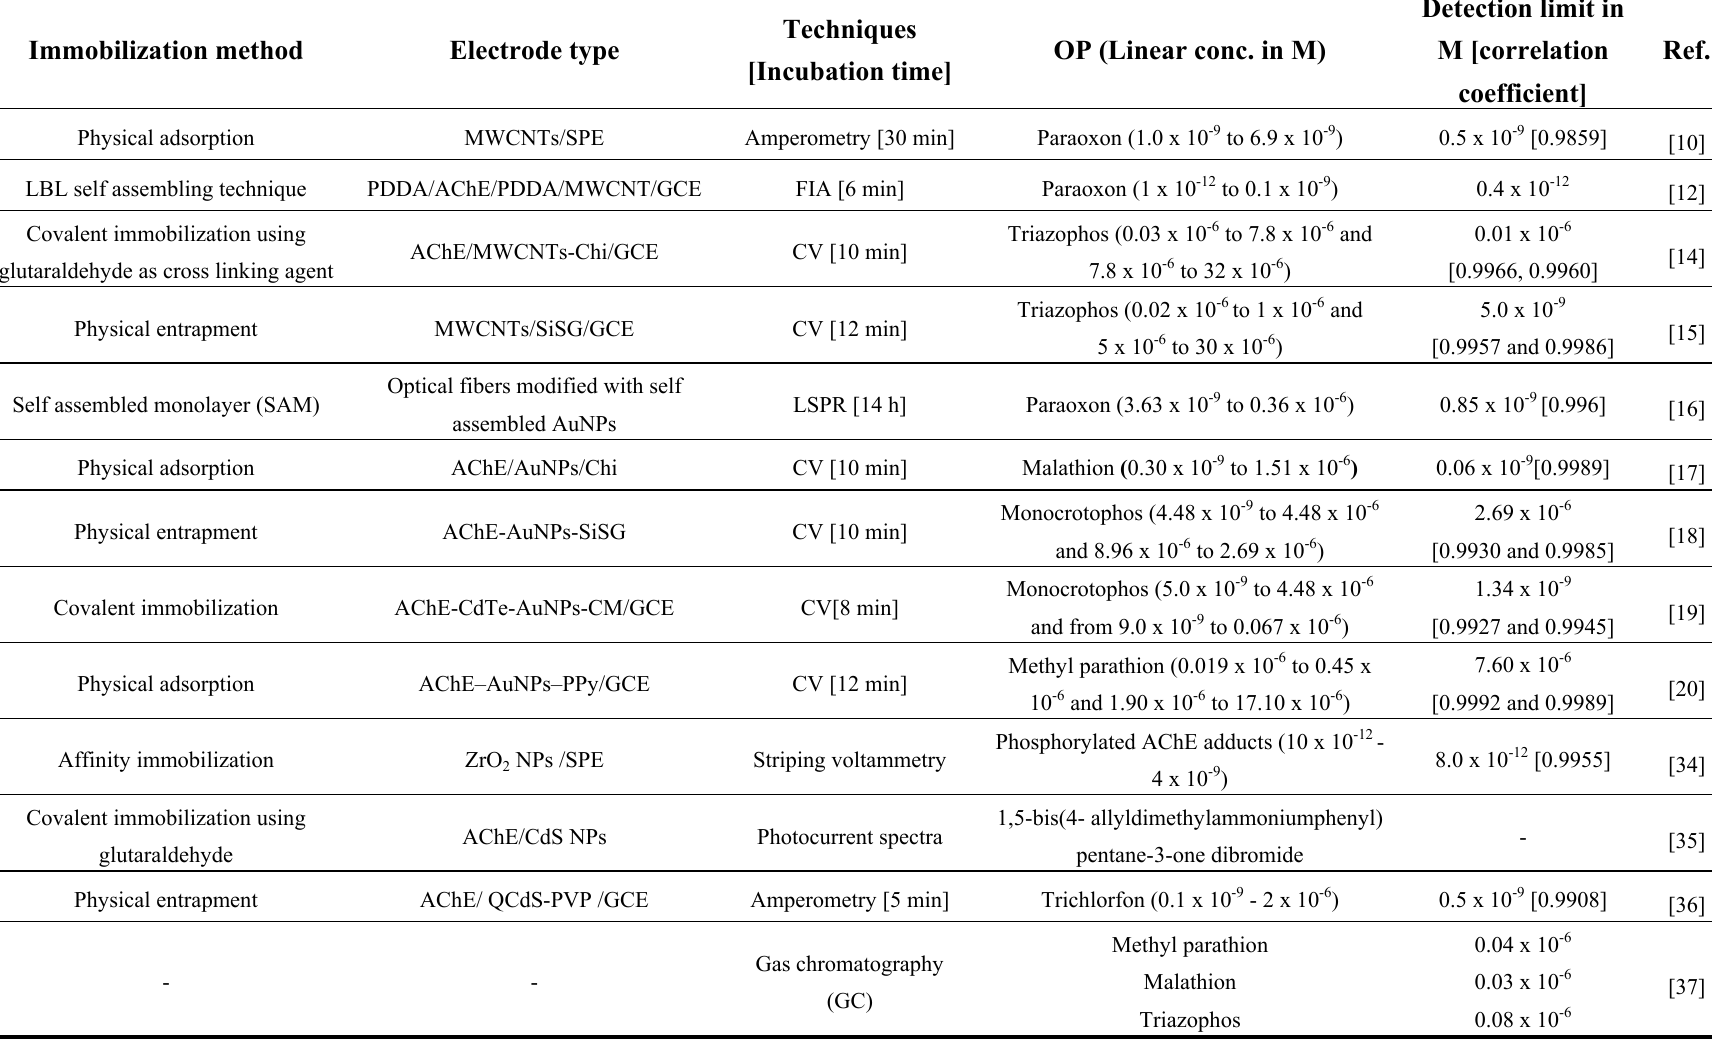
Table 1. Comparison of performance characteristics of nanomaterial based AChE sensors with chromatographic techniques and